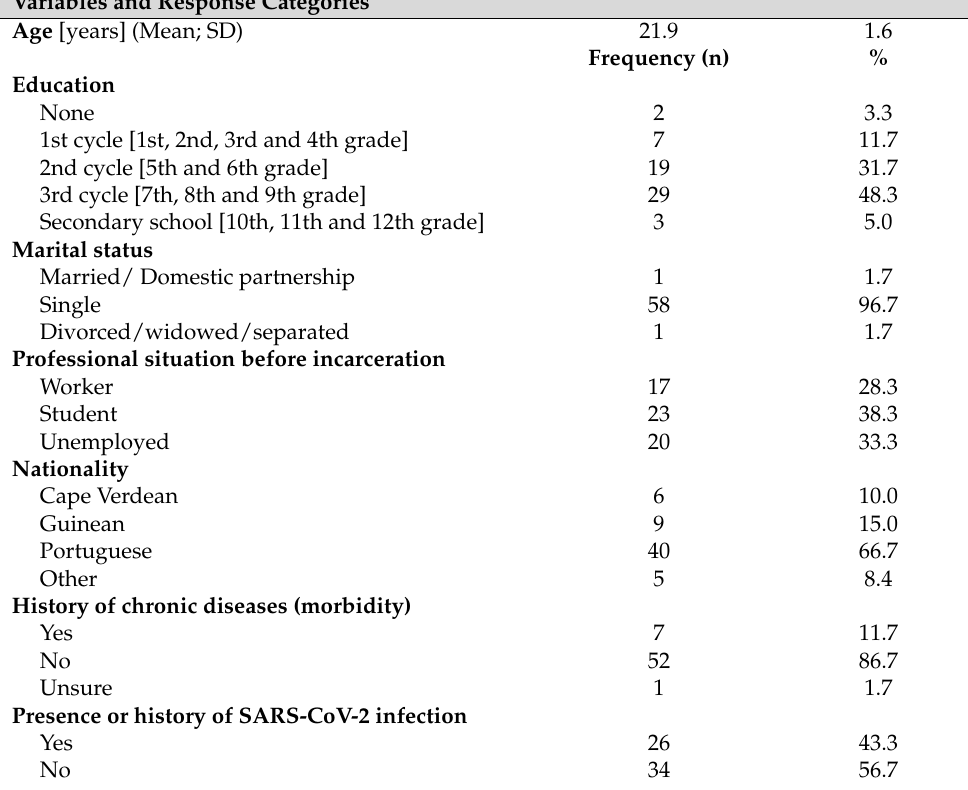
Table 1. Background characteristics of study participants (n =